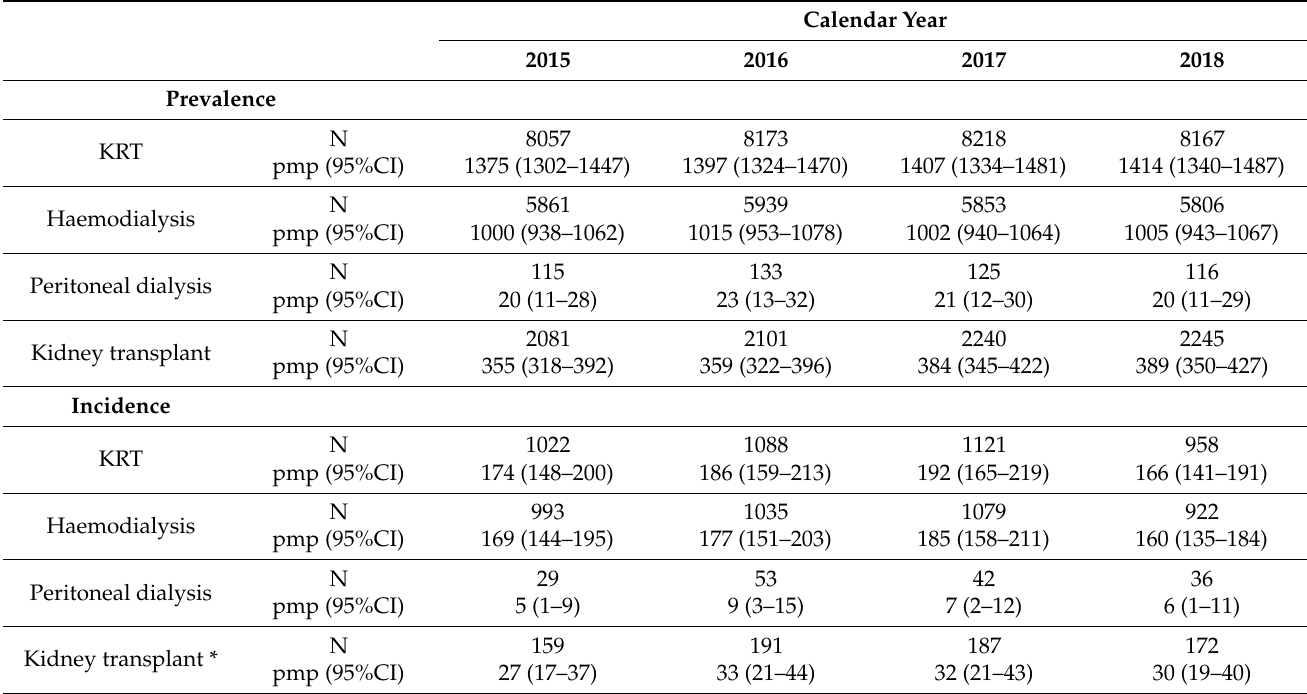
Table 1. Prevalence and de novo incidence of kidney replacement treatment among residents of Campania by calendar year: absolute counts (N) and count per million population (pmp) with